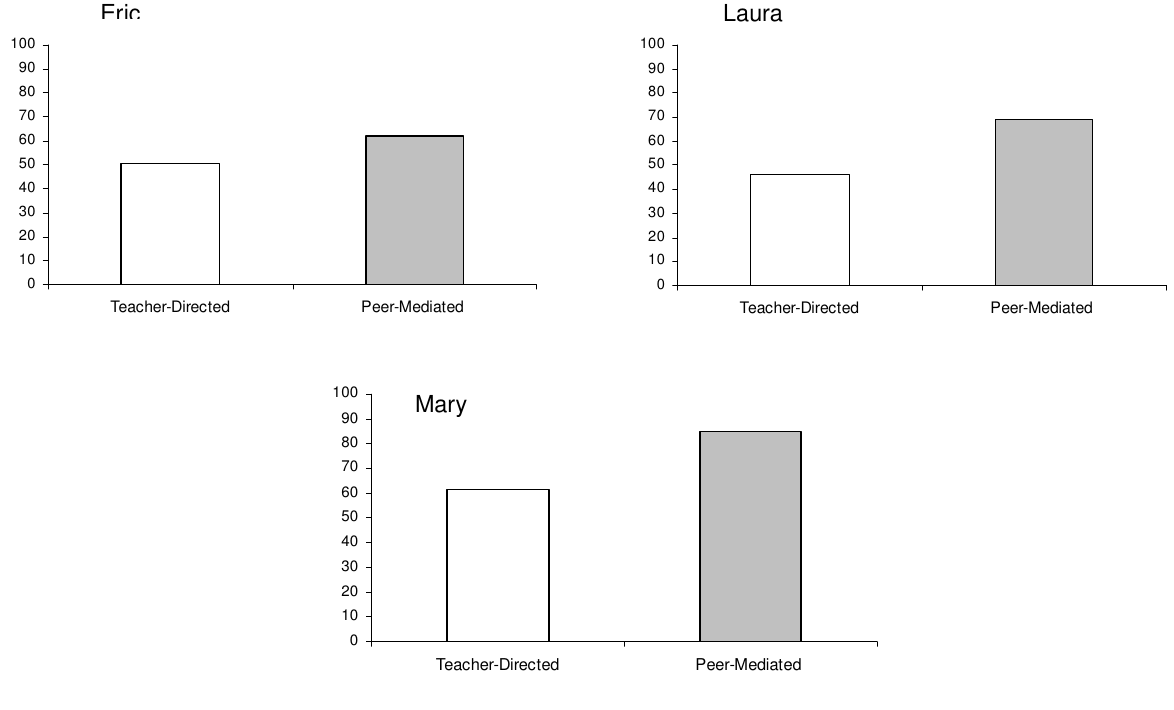
Mean percentage of intervals in activity engagement for students with SMD teacher-directed and peer-mediated